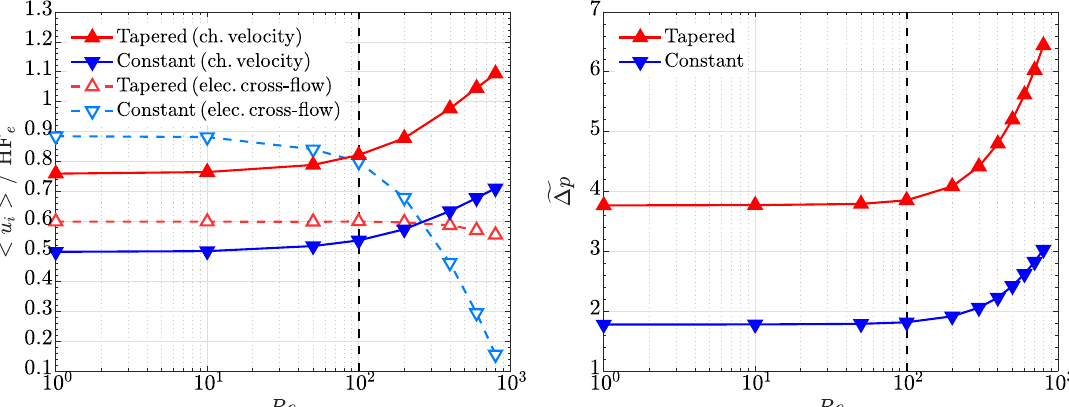
Figure 4. Variation of ( left ) the average axial velocity in the inlet channel, (cid:104) ˜ u i (cid:105) , and the homogeneity factor of the transverse velocity in the electrode, HF e , and ( right ) the overall pressure drop, (cid:102) ∆ p , as a function of the Reynolds number, Re , corresponding to the constant cross-section and tapered flow fields. Electrode permeability, K e = 10 − 10 m 2 ( γ ∼ 1 ) , and Λ =